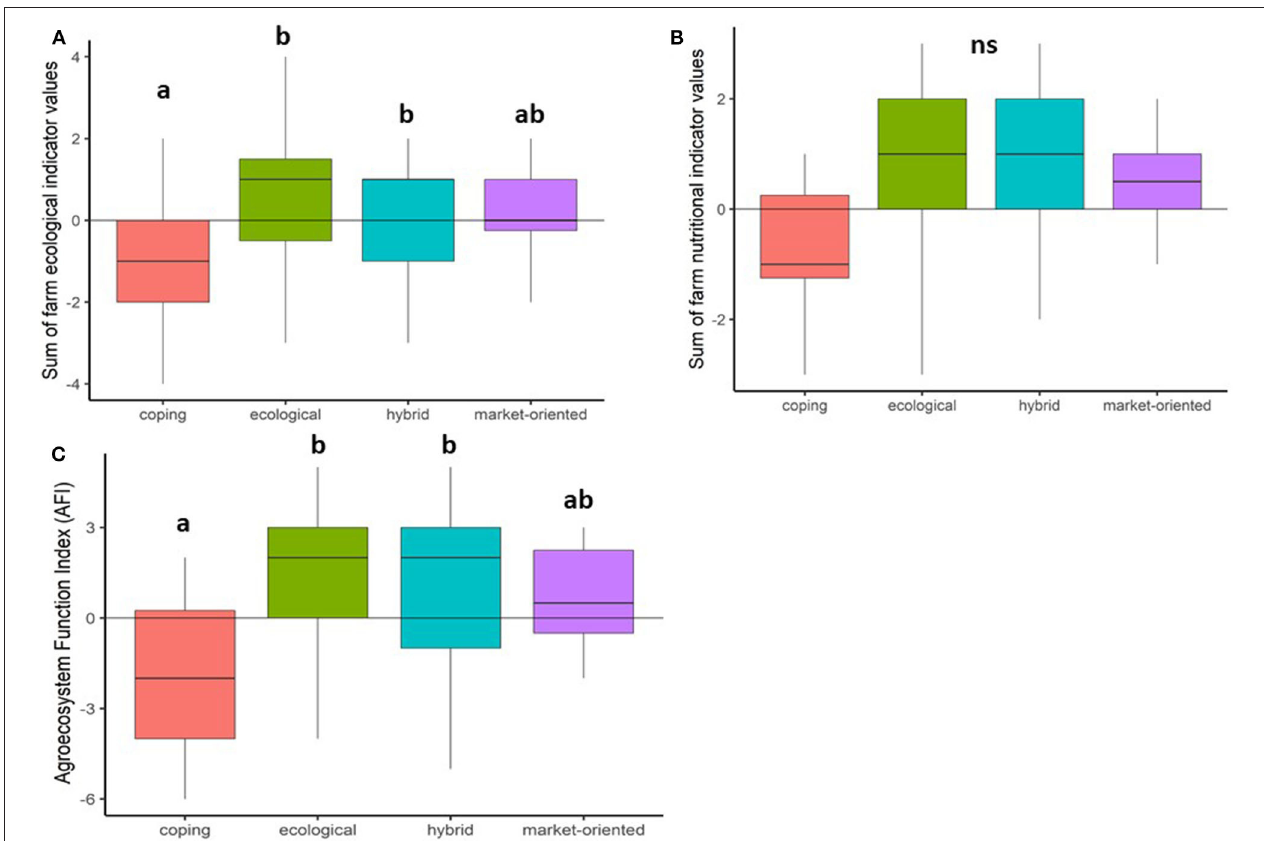
FIGURE 4 | Coping and adaptation strategies in smallholder agroecosystems in Sarstun, Guatemala. Farmer strategies to cope or adapt to shocks are shown in relation to the ecological (A) , nutritional (B) , and overall sums of indicators represented by the Agroecosystem Function Index (AFI) (C) . Primary adaptation strategies were ecological, market-oriented, or a hybrid approach using both ecological and market-oriented practices. Coping strategies included renting land, off-farm work on plantations, and increasing pesticide use. Ecological strategies included incorporating agroforestry techniques, use of leguminous cover crops, and integrating multiple crop diversification practices. Market-oriented strategies included increasing crop sales, growing hybrid maize varieties, and higher fertilizer and pesticide application rates. Different letters indicate significant differences by household coping or adaptation strategy ( p < 0.05; Tukey’s HSD). Village was included as a random effect in all